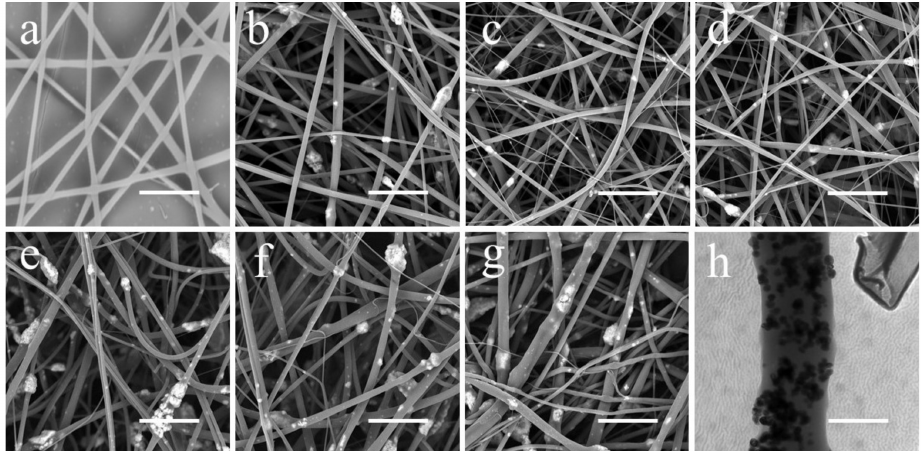
Figure2. SEMimagesof( a )PVPand( b )PVP / γ -Fe 2 O 3 nanofibersfabricatedbynear-fieldelectrospinning (NFES) without an auxiliary magnetic field, and ( c – g ) PVP / γ -Fe 2 O 3 nanofibers fabricated by MES; ( c – e ) PVP / γ -Fe 2 O 3 nanofibers with a mass ratio of γ -Fe 2 O 3 being 1 wt % and di ff erent magnetic field strengths; ( c ) 30 mT, ( d ) 93 mT, and ( e ) 154 mT. PVP / γ -Fe 2 O 3 nanofibers with a magnetic field strength of 93 mT and di ff erent mass ratios of γ -Fe 2 O 3 being ( f ) 2 wt % and ( g ) 3 wt %. ( h ) TEM image of PVP / γ -Fe 2 O 3 nanofibers fabricated by MES with a magnetic field strength of 93 mT and a mass ratio of 1 wt %. The scale of ( a – g ) is 5 µ m, and the scale of ( h ) is 600 nm.